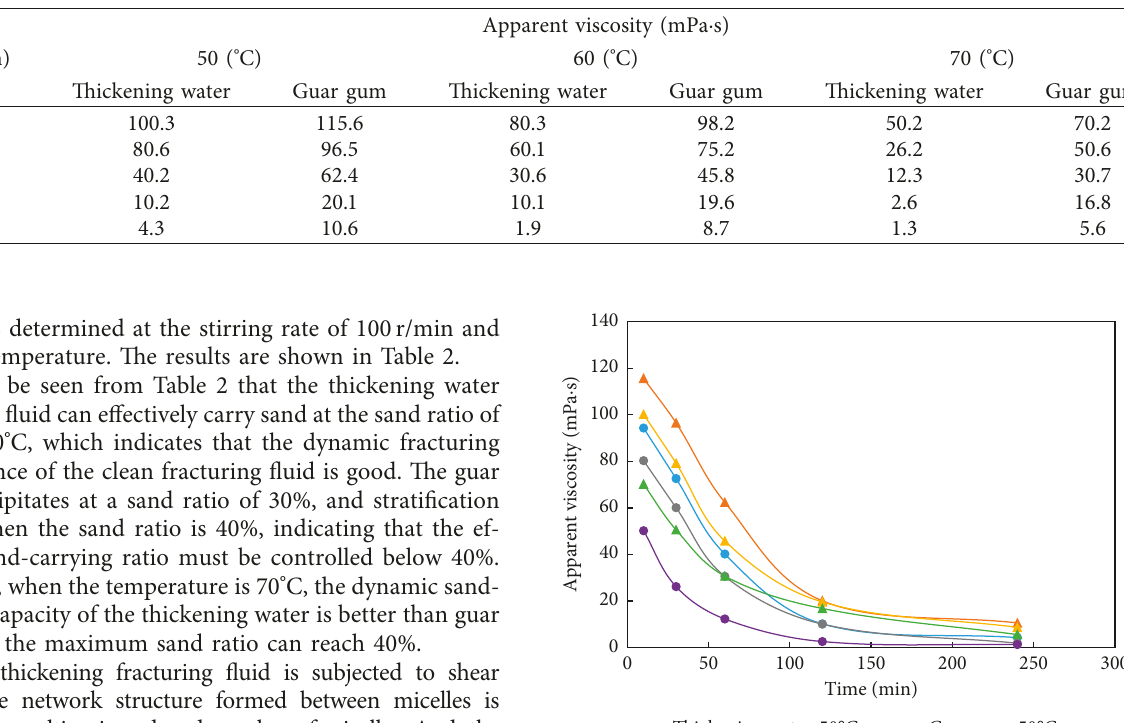
Table 3: Comparison of gel breaking property of two kinds of fracturing fluids.